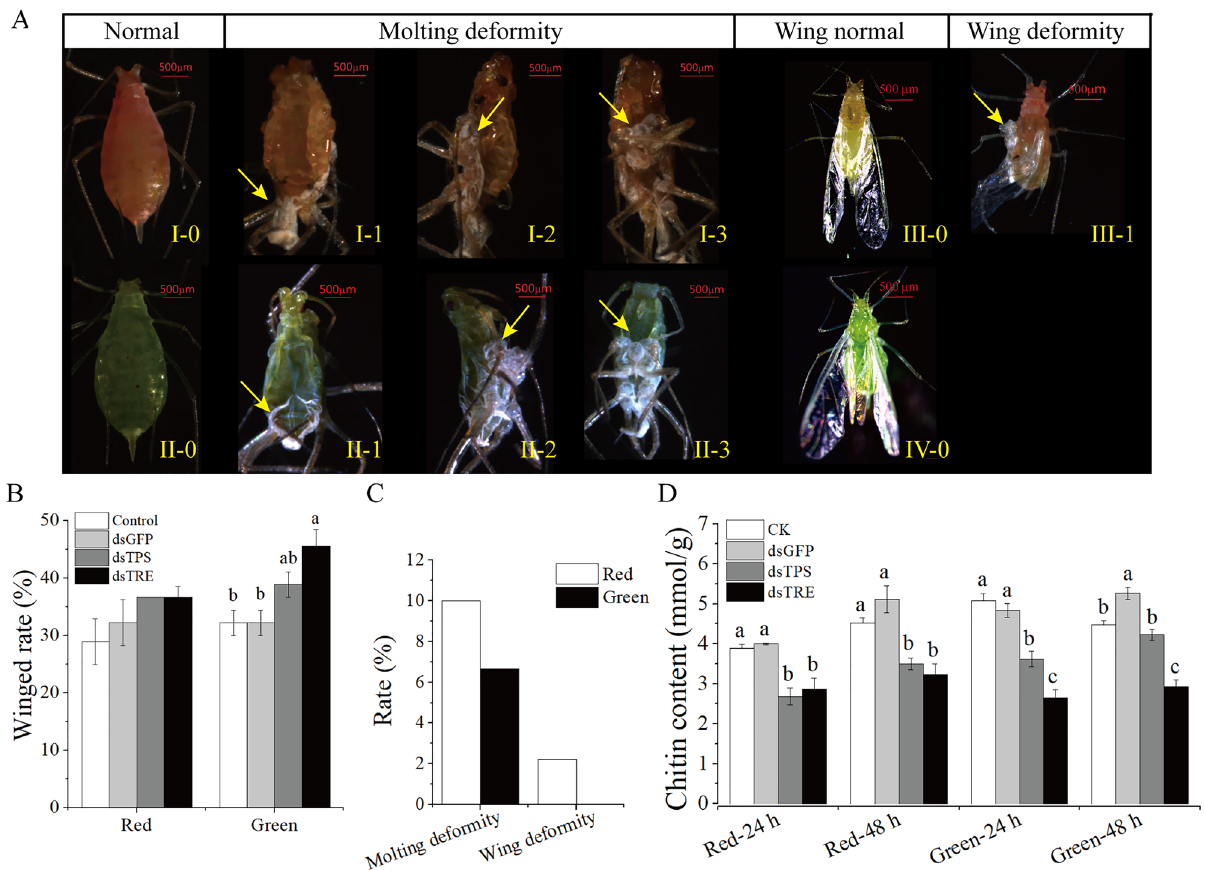
Figure 3. Effect of RNAi on phenotype and chitin content. ( A ) Representative phenotypes of A. pisum after RNAi. I-0 and II-0: normal phenotypes as control phenotype; II-3: abnormal phenotypes in the red morphs, the “molting deformity” phenotype; III-3: abnormal phenotypes in the green morphs, the “molting deformity” phenotype; III-0 and IV-0: normal winged and III-1: abnormal phenotype in the red morphs, the “wing deformity” phenotype. All abnormal insects in the nymph-adult stage were present. ( B ) The winged rate after RNAi. ( C ) The abnormal phenotype rates. ( D ) The chitin content after RNAi. Red, red morphs of A. pisum . Green green morphs of A. pisum , CK the normal diet, dsGFP the GFP-dsRNA treatment, dsTPS the TPS-dsRNA treatment, dsTRE the TRE-dsRNA treatment. Each bar represents the Means ± SEM from three biological replicates with ten individuals mixed in each replicate. The data were analyzed using one-way analysis of variance (ANOVA), followed by the Tukey–Kramer test. The different letters above the error bars indicate significant differences ( P < 24 h (Fig. 4B,D). The expression of ApHK , ApGPI and ApGP was significantly increased at 48 h, only ApUAP expression was significantly down-regulated at 48 h by RNAi of ApTPS (Fig. 4B,D).